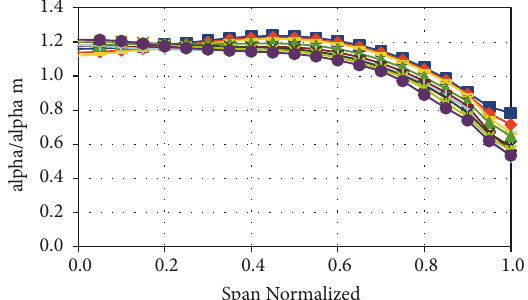
Figure 10: 𝜂 ts vs PRF in partial hub admission, CFD (blue) and experimental data (green).